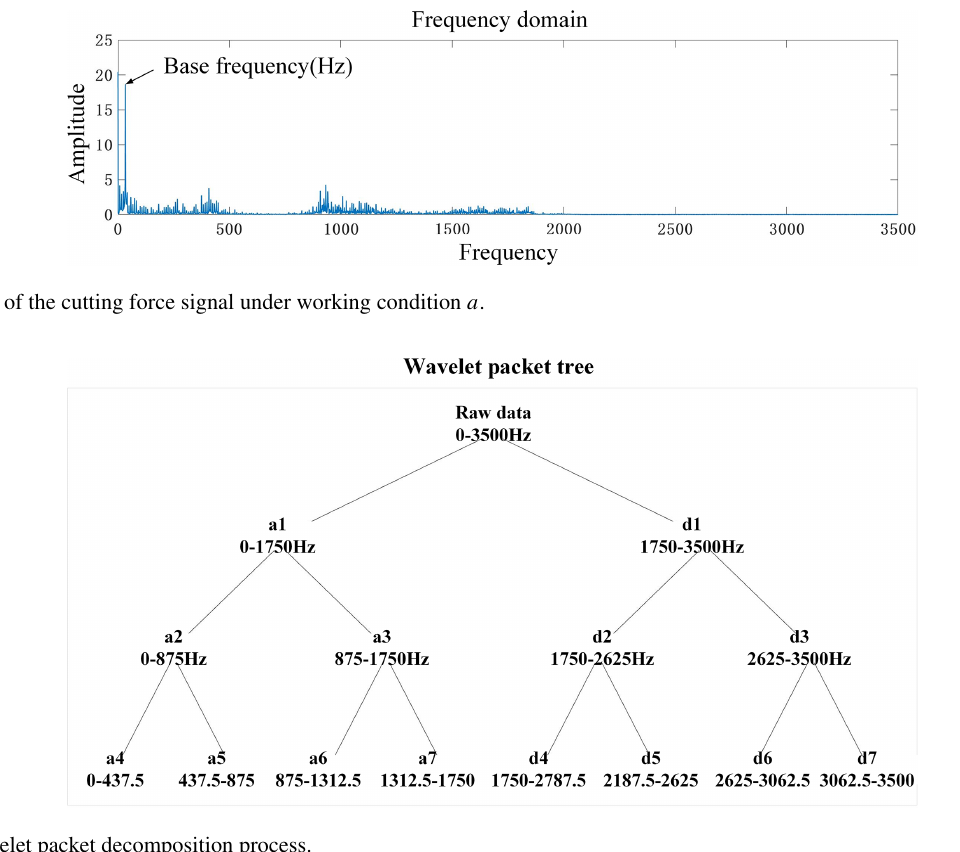
Figure 7. Wavelet packet decomposition process.